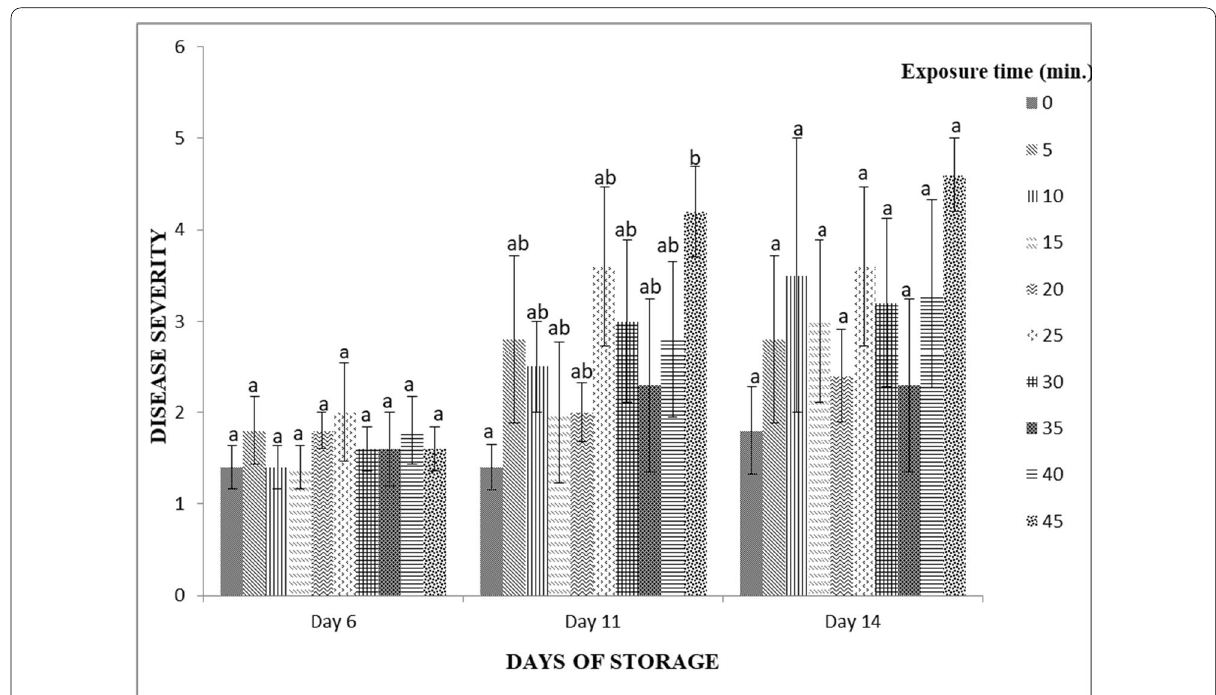
Fig. 2 Effect of exposure to gasoline fuel emission on severity of rot caused by Fusarium oxysporum on unwounded tomato fruits